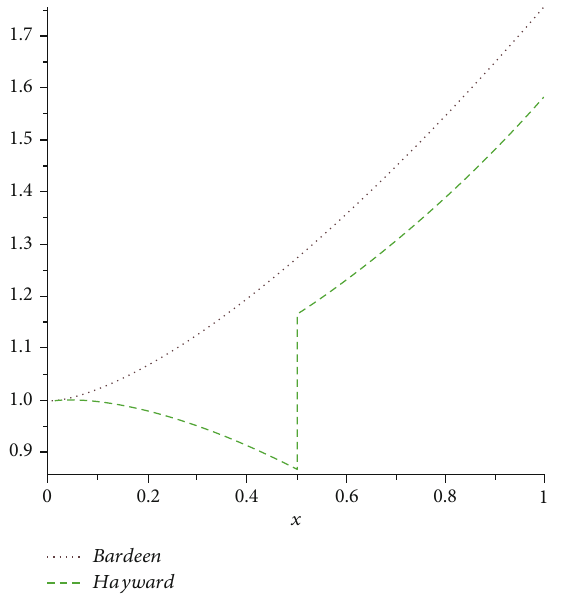
π 4 (cid:2) 1/3 is 0